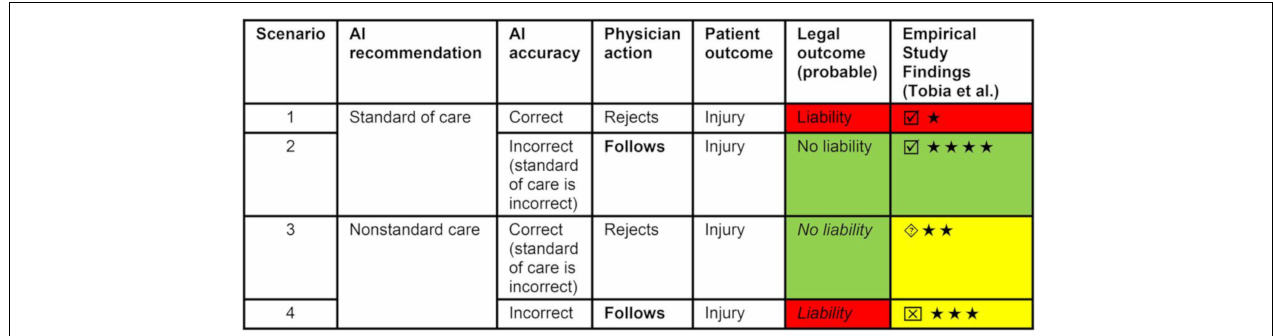
FIGURE 3 | Comparison of potential legal outcomes under current law according to analysis of Price et al. (2019) and empiric study findings of Tobia et al. (2021). = agreement that physician decision was reasonable (highest is ; lowest is ). Greater agreement indicates lower likelihood of liability; = study results confirming Price et al.’s analysis of current tort law; study results suggesting that jury outcome may also be liability; study results suggesting that jury might decide no liability. Reproduced from Price et al. (2021). ©